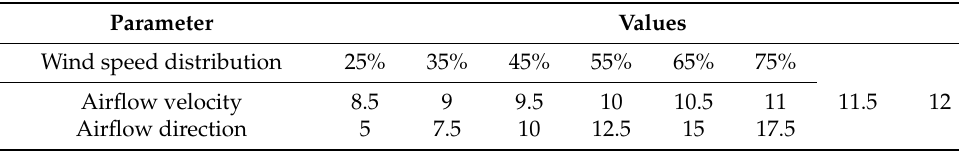
Table 5. Parameters used in single-factor